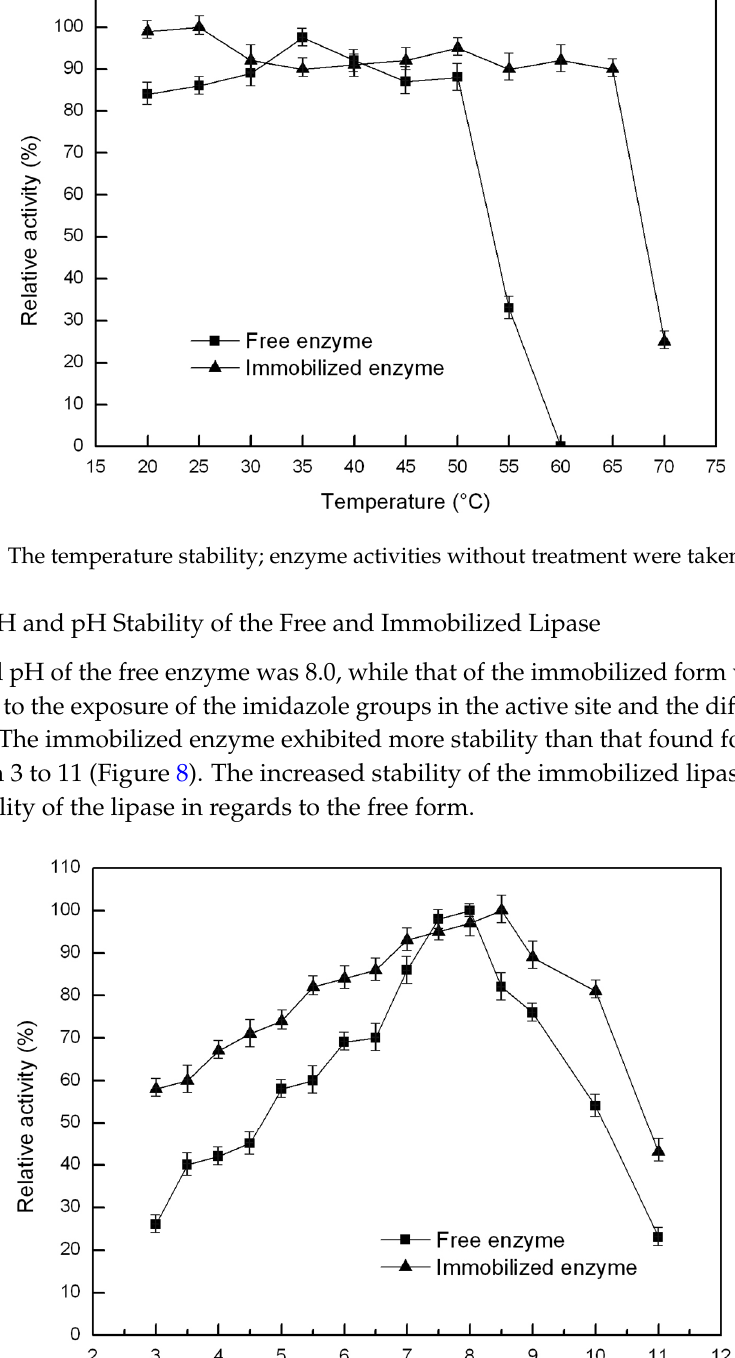
Figure 7. The effect of pH on the free and immobilized enzyme.